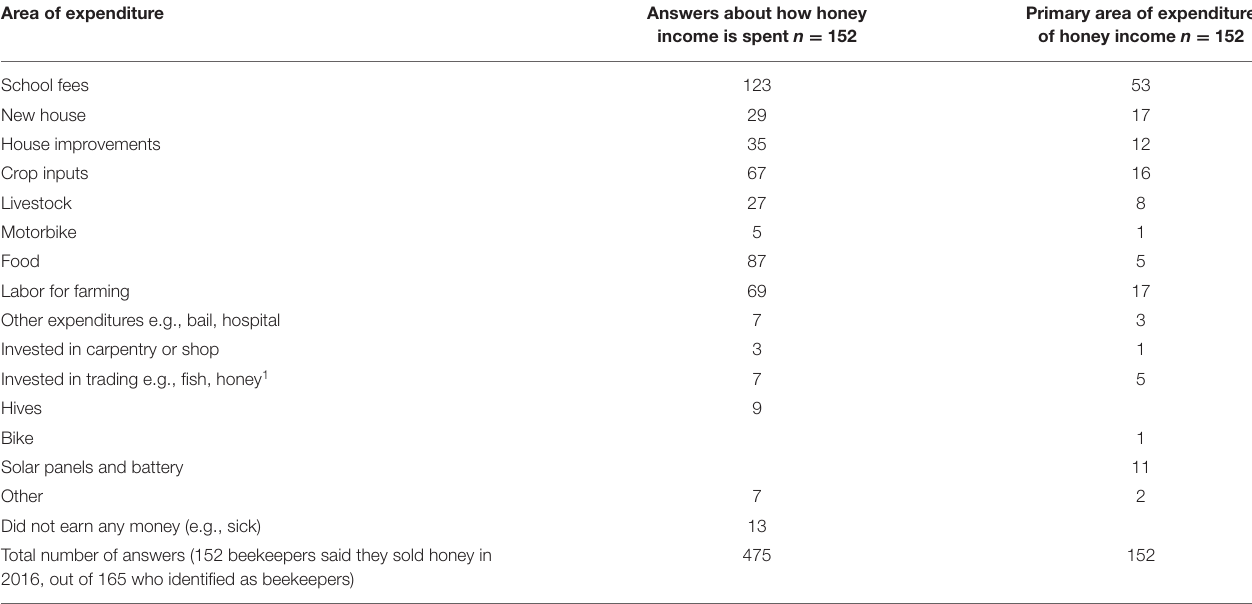
TABLE 10 | Areas of expenditure of income earned from selling honey in early